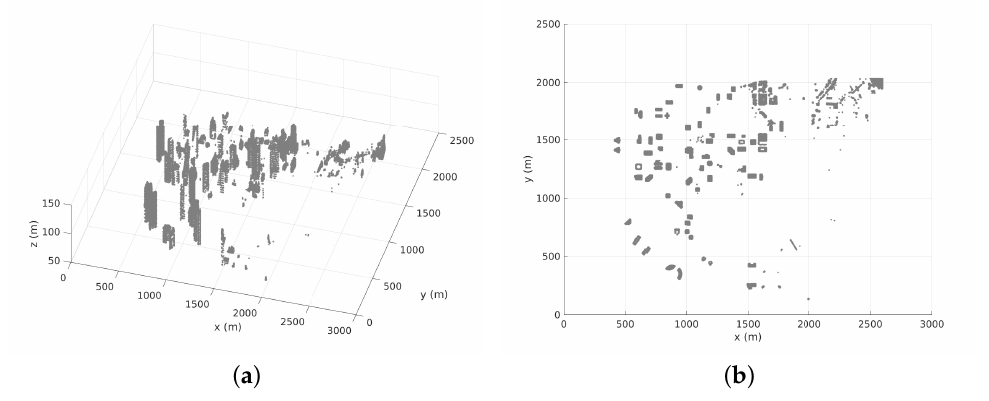
Figure 4. An example city of urban modeling ( a ) 3D ( b )